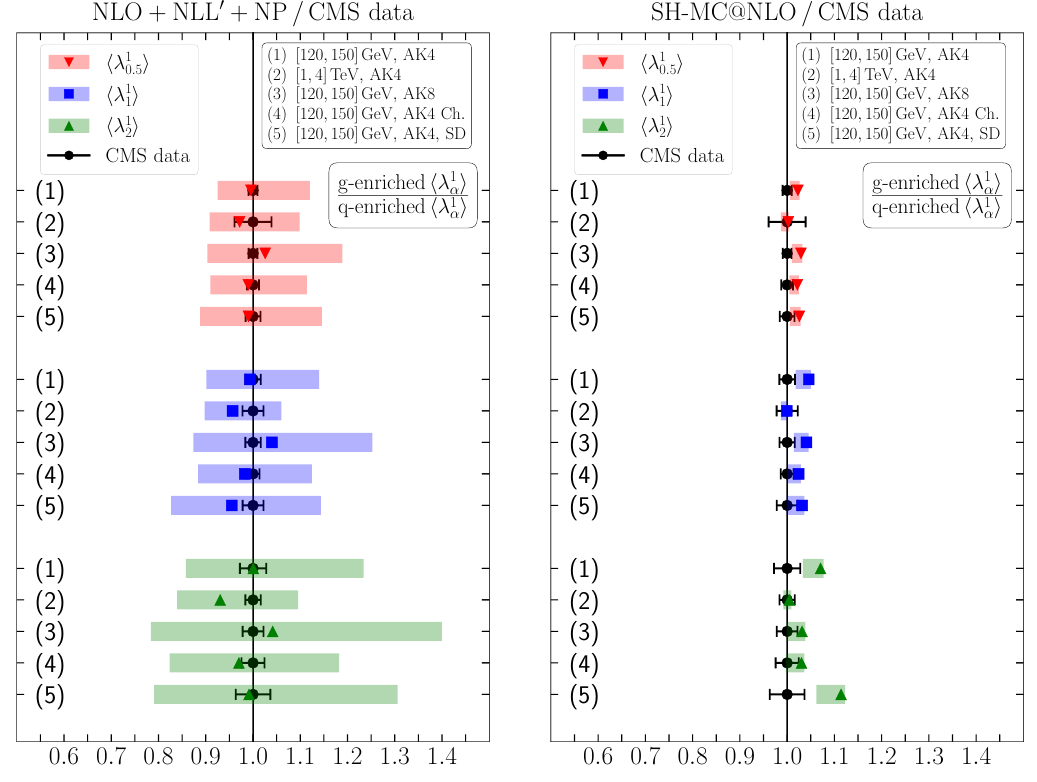
Figure 12. Ratio of jet-angularity mean values for the gluon- and quark-enriched samples in the five phase-space regions detailed in table 2. The results obtained from the NLO + NLL 0 + NP calculation (left) and the SH-MC@NLO simulation (right) here get divided by the respective value reported by CMS